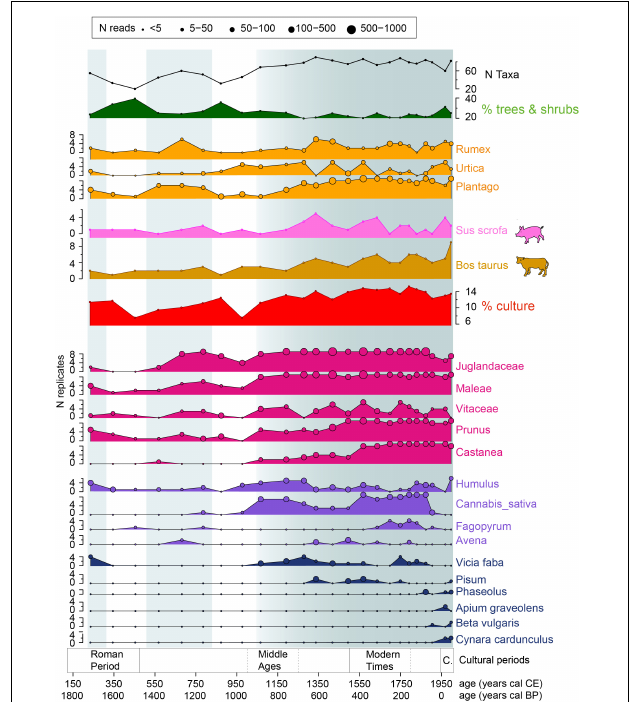
FIGURE 8 | Main plant and mammal DNA results illustrating the evolution of forest cover (% of DNA reads from trees and shrubs), the number of taxa detected and the diverse farming activities (pastoralism, livestock farming, fruit tree cultivation, cultivated fields with cereals or other plants and garden plants). Blue areas highlight main phases of agricultural